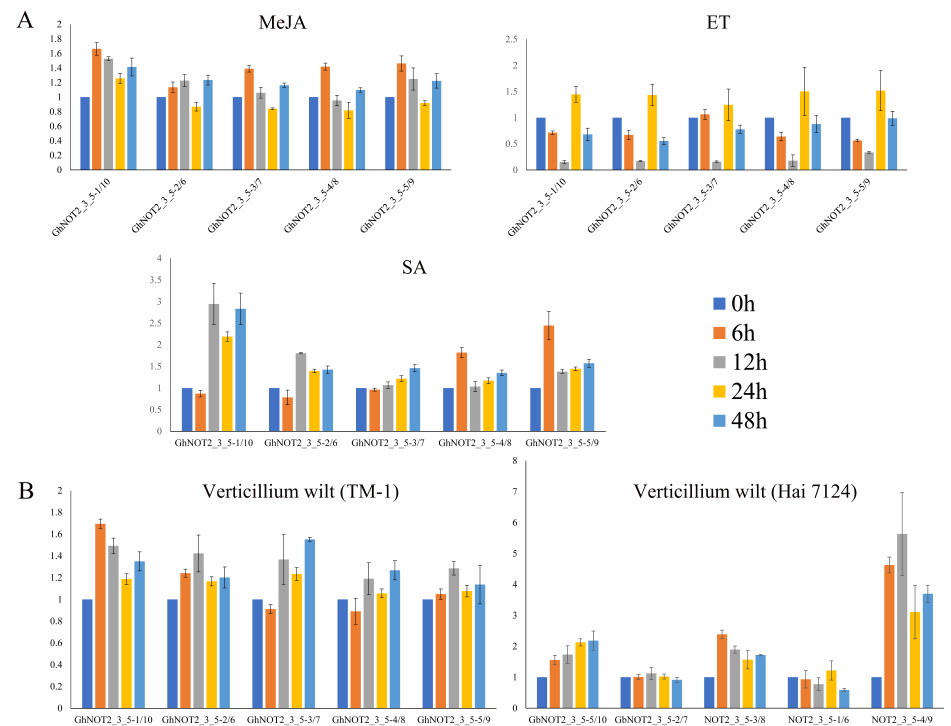
Figure 7. Expression patterns of NOT2_3_5 genes under exogenous hormone and after infection of V. dahlia using qPCR. ( A ) Expression patterns of NOT2_3_5 genes in G. hirsutum var TM-1 under exogenous hormone, including SA, MeJA and ET, treatment. ( B ) Expression patterns of NOT2_3_5 genes in G. barbadense var Hai 7124 after infection of V. dahlia